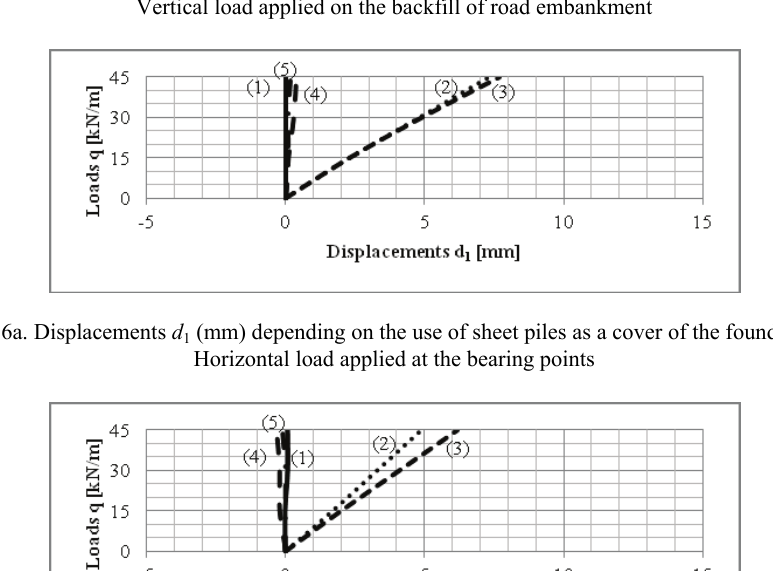
Fig. 5d. Displacements d x (mm) depending on the use of sheet piles as a cover of the foundation. Vertical load applied on the backfill of road embankment